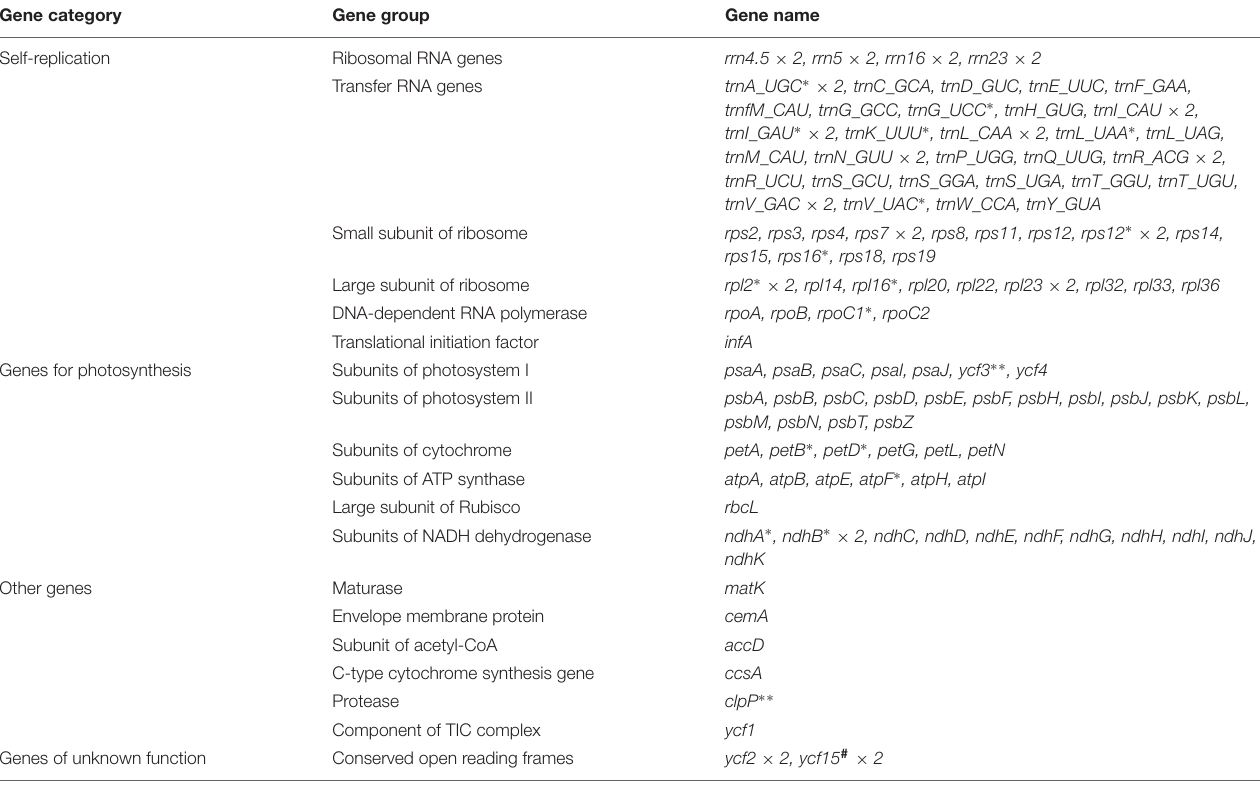
TABLE 2 | List of genes identified in the chloroplast genomes of Davidia involucrata , Camptotheca acuminata , and Nyssa sinensis. Gene